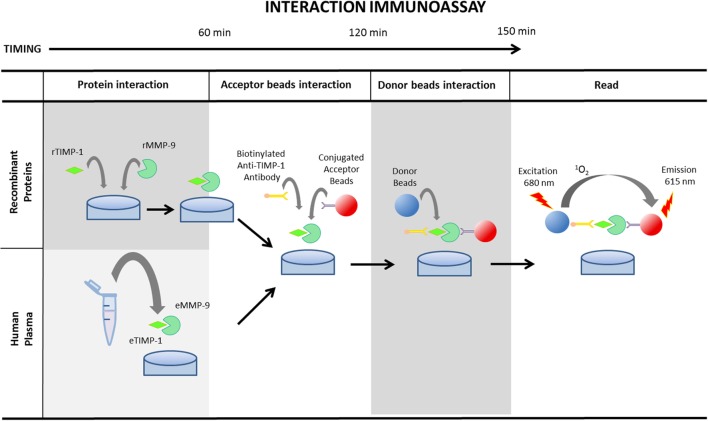
Schematic illustration of AlphaLISA® protein interaction determination protocol using recombinant matrix metalloproteinase (MMP)-9 and tissue inhibitor of metalloproteinase (TIMP)-1 proteins or endogenous MMP-9 and TIMP-1 in human plasma. MMP-9 and TIMP-1 recombinant proteins need 1 h incubation at room temperature to promote the interaction. The subsequent step consists of the incubation of the sample or the recombinant proteins with the conjugated acceptor beads and the biotinylated anti-TIMP-1 antibody for an additional 1 h. Finally, after the incubation of the mixture with the donor beads for 30 min, the plaque should be read at 680 nm.